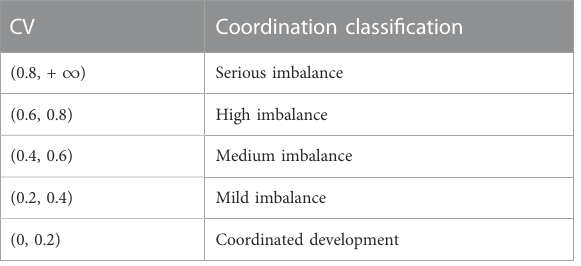
TABLE 3 Coordination classi fi cation of UCLUC.